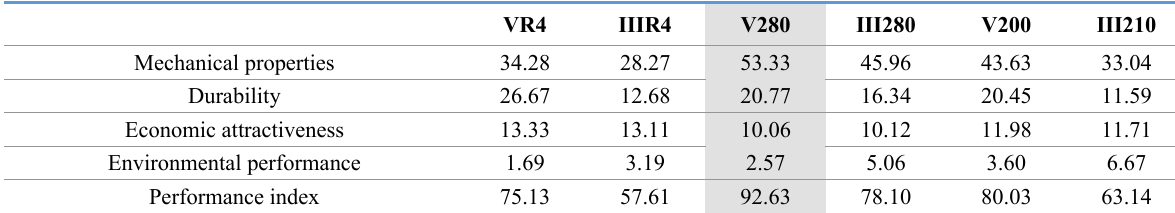
Table 11. Final Performance Index (Scenario 2 - Building structure).